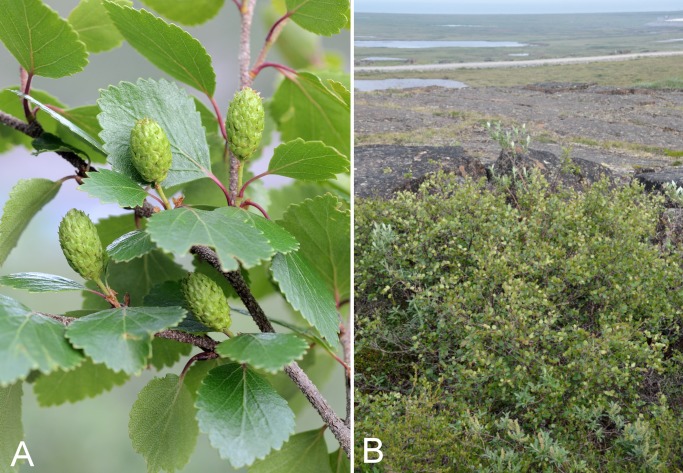
Betula occidentalis.(A) Pistillate catkins, Saarela et al. 4079. (B) Habit, Saarela et al. 4318. Photographs by R. D. Bull.